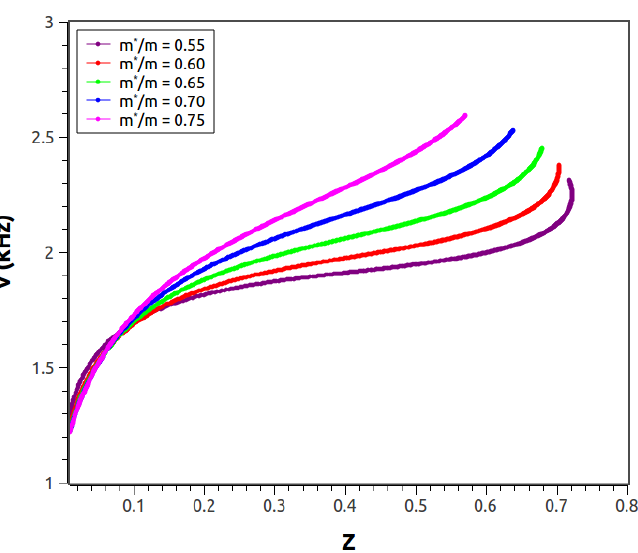
Figure 8. The f -mode frequencies, ν , as a function of gravitational redshift, Z , for varying m ∗ / m